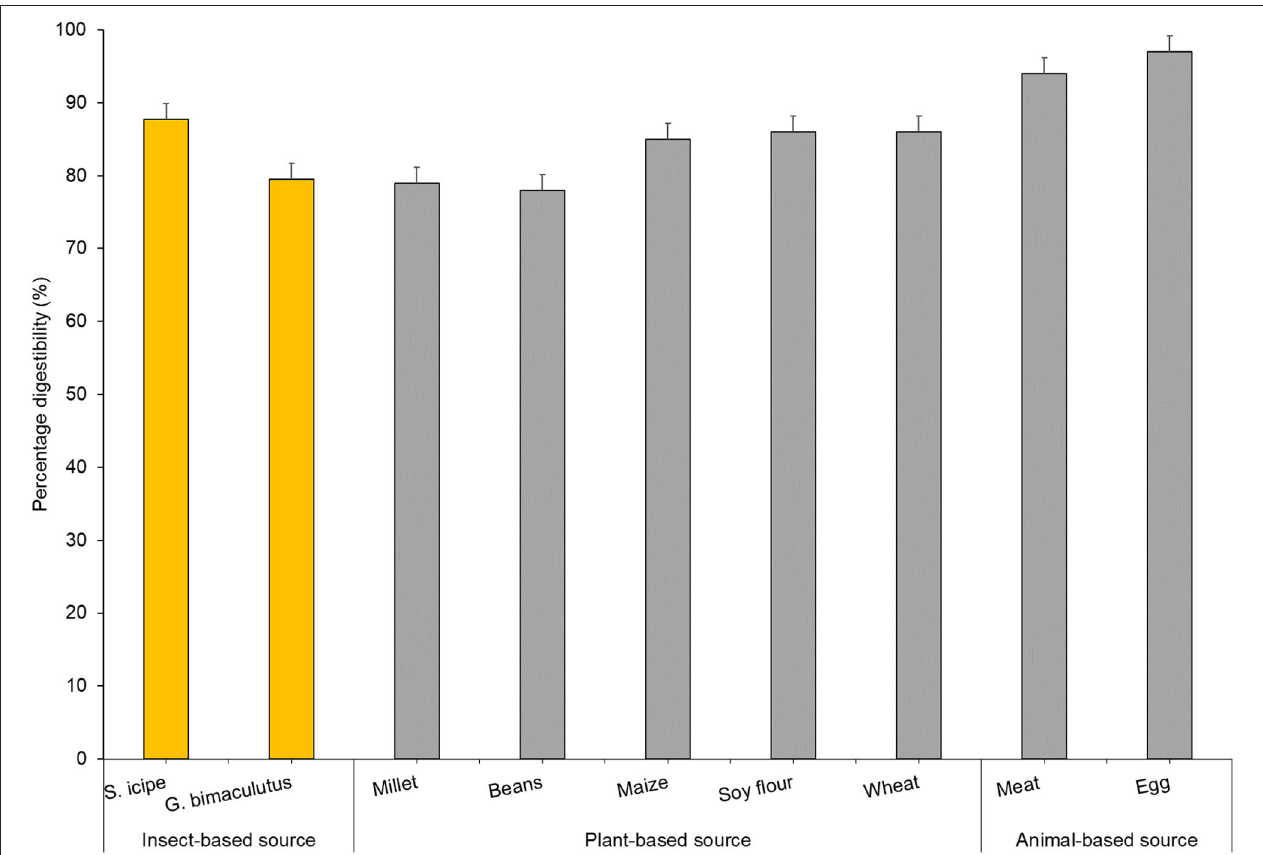
FIGURE 2 | Comparative analyses of in vitro protein digestibility of crickets ( Scapsipedus icipe and Gryllus bimaculatus ), plants and animal food sources. Data for plant and animal sources was extracted from FAO/WHO/UNU ( 56).